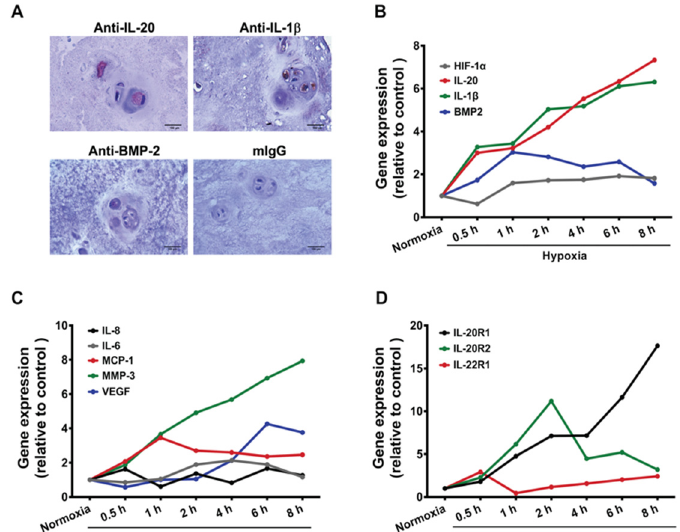
Figure 1. E ff ects of hypoxia stimulation on gene expression of intervertebral disc (IVD) cells. ( A ) Expression of interleukin (IL)-20, IL-1 β , and bone morphogenetic protein (BMP)-2 in intervertebral disc herniation (HIVD) sections were determined using immunohistochemical (IHC) staining with specific antibodies. Staining with isotype mouse immunoglobulin G (IgG) was used as the negative control. Scale bars = 100 µ m. All experiments were performed three times with similar results. Data are from a representative experiment. ( B – D ) Primary cultured IVD cells (1 × 10 6 cells / well) were exposed to a hypoxic environment for 0.5, 1, 2, 4, 6, and 8 h (h). The expression levels of indicated genes were analyzed using real-time quantitative polymerase chain reaction (RT-qPCR) with specific primers. β -actin was an internal control. Data are expressed as mean and are representative of three independent experiments. VEGF, vascular endothelial growth factor; MMP-3, matrix metalloproteinase-3; MCP-1, monocyte chemoattractant protein